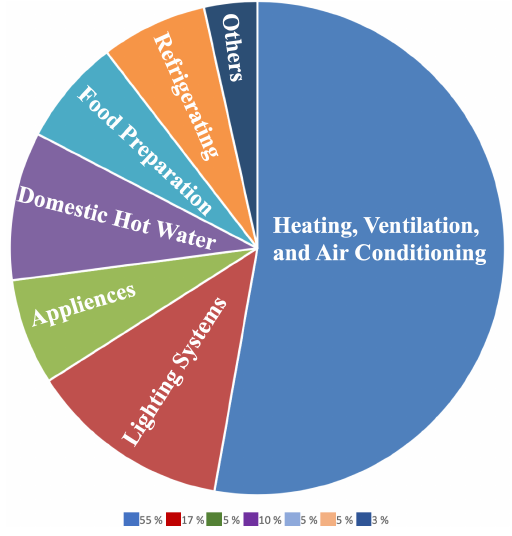
Figure 4. Share of residential energy